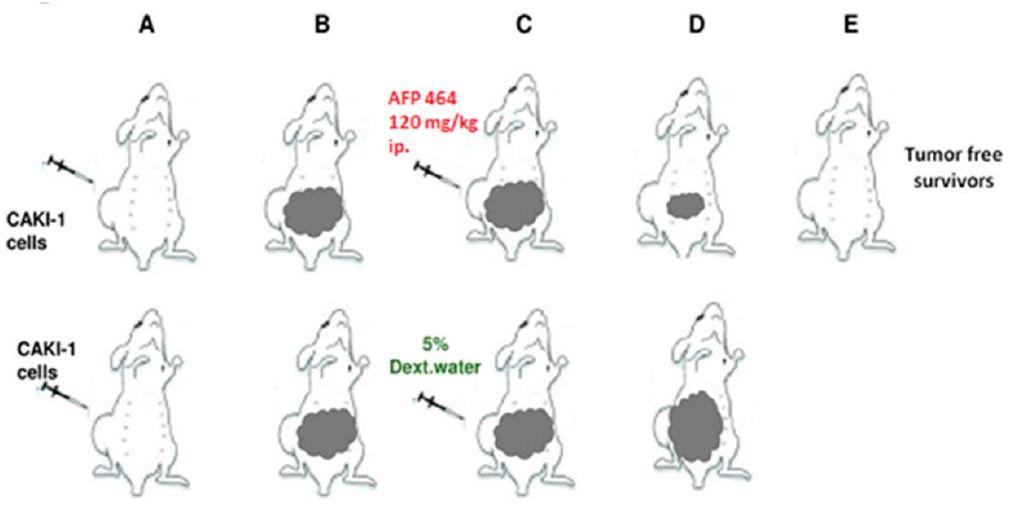
Figure 3. In vivo antitumor activity of aminoflavone (AF) against a Caki-1 human renal tumor (Figure reproduced from